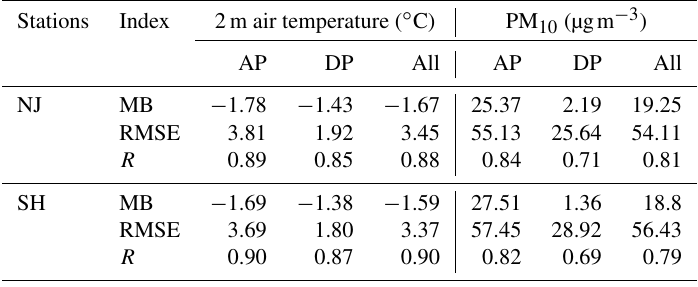
Table 2. Statistical analyses of the simulated meteorological variables and PM 10 versus the ground observations. MB, RMSE and R refer to mean bias, root-mean-square error and correlation coefficient, respectively, and AP and DP refer to the anthropogenic-dominated period and dust-dominated period.